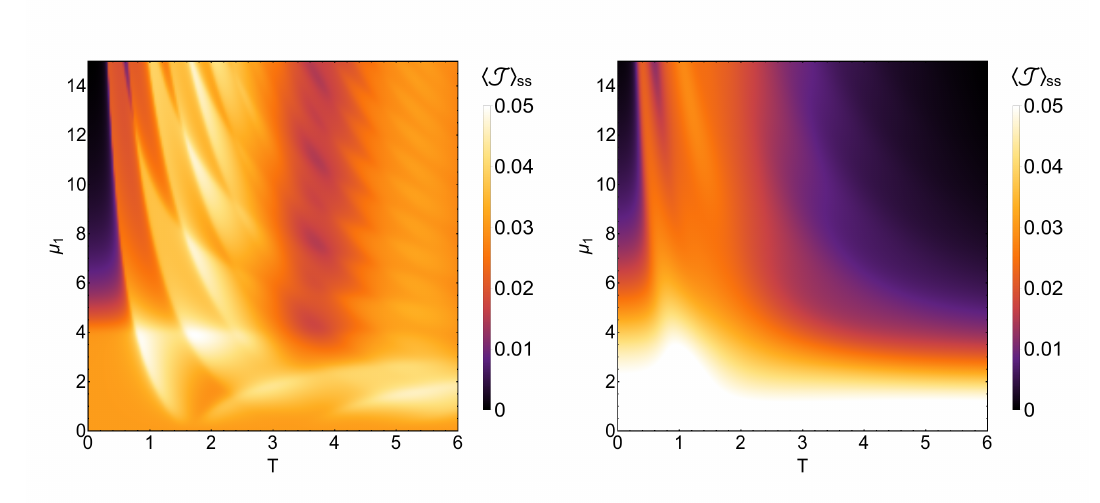
Figure 7: Floquet steady state expectation values of the current J under PBC. On the left panel (weak system-bath coupling g = 0.1), the current appears to be sensi- tive to the total winding number | ν ( g = 1.0) causes the resonance structure to largely disappear. The remaining param- eters are: J = 1, γ = 0.8, ∆ = 0.3, µ